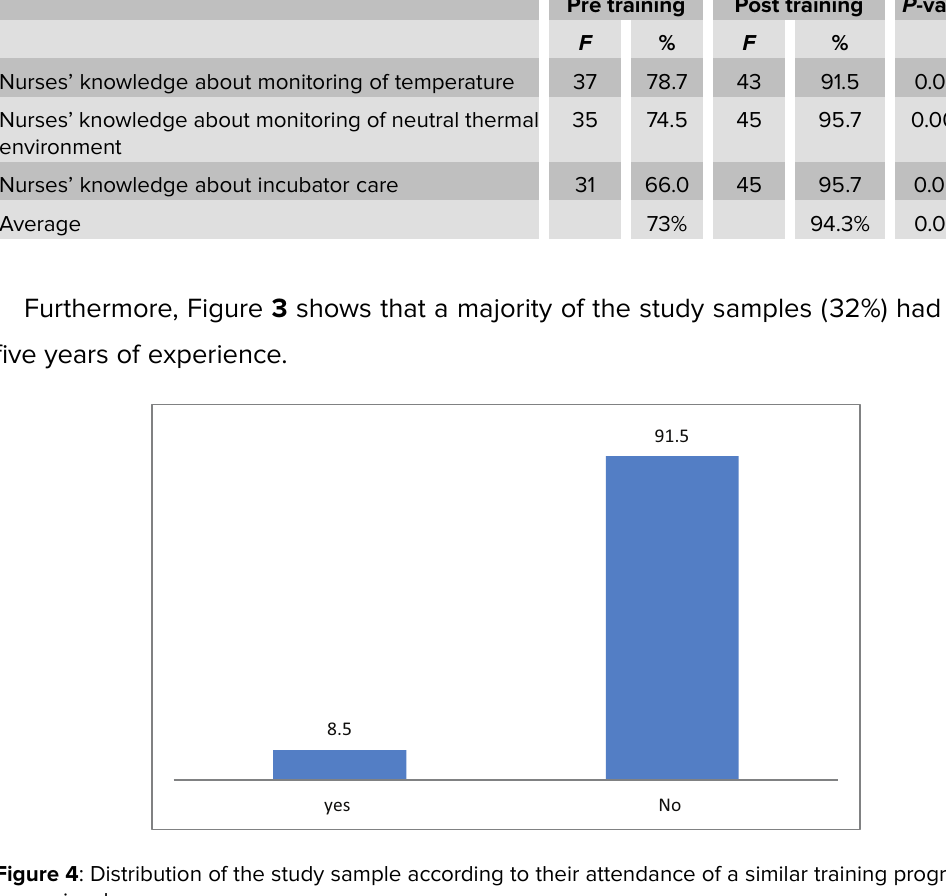
Figure 4 : Distribution of the study sample according to their attendance of a similar training program prior to